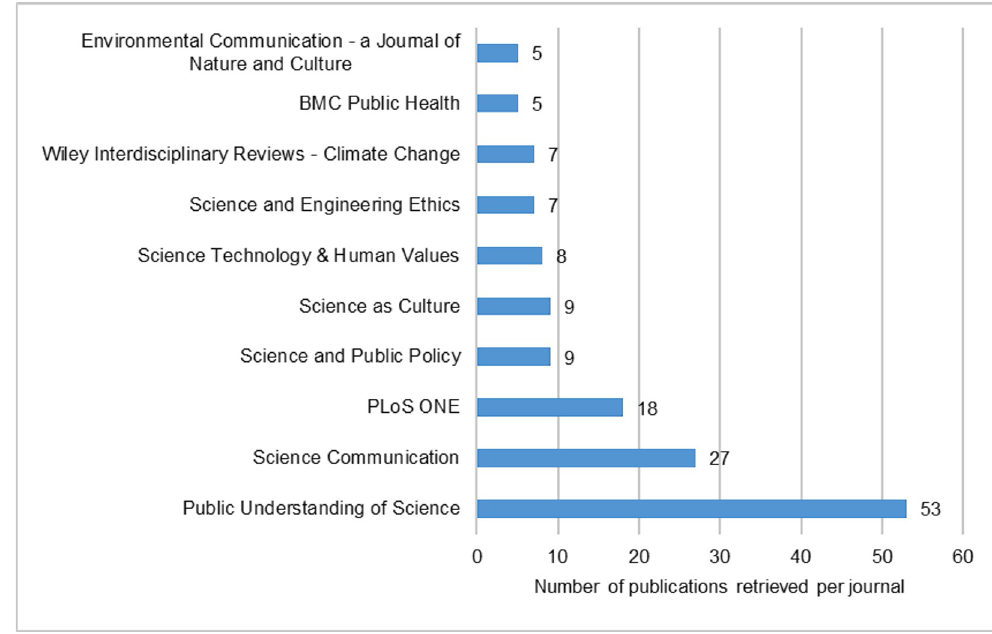
Fig 2. Top 10 academic journals among publications with a combination of the terms ‘public engagement’ and ‘science’ in their titles or abstracts in the Web of Science for the period 1995–2019.